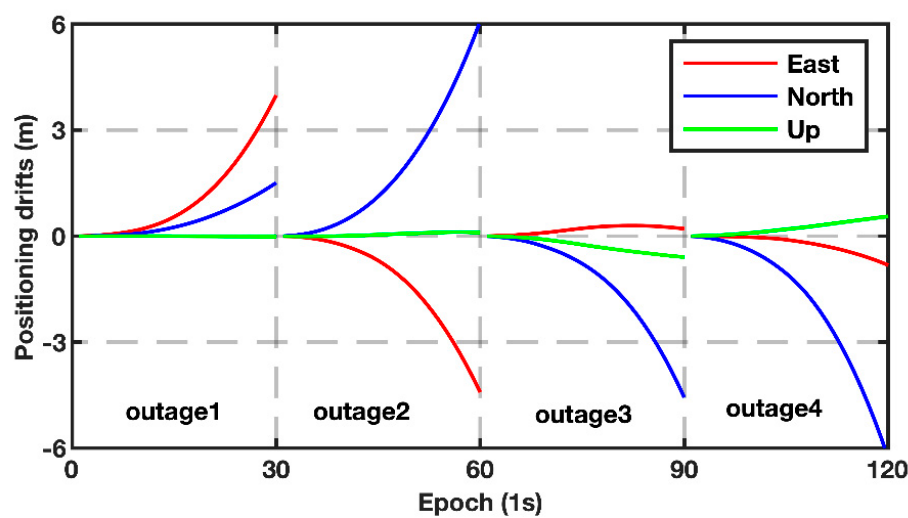
Figure 5. Positioning errors of the PPP-B2b/MEMS − IMU loosely coupled integration during the simulated GNSS signal outages.